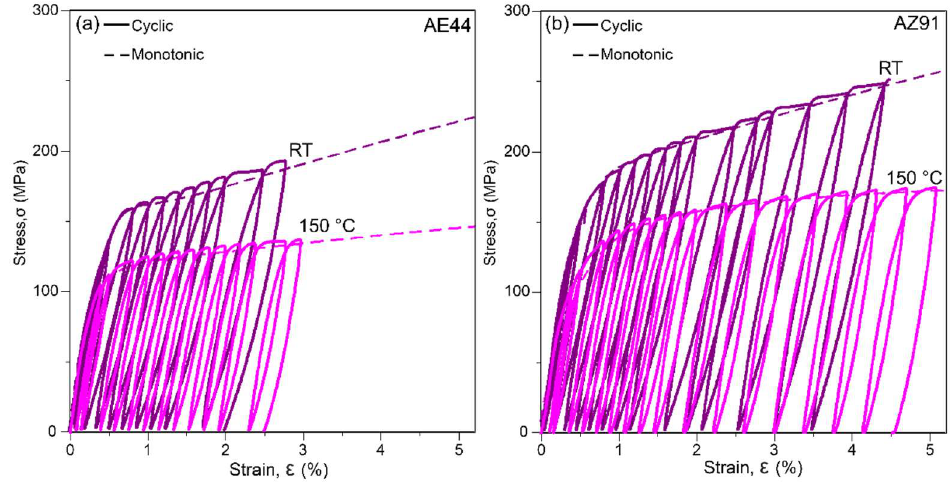
Figure 3. Examples of hysteresis loops in as-cast ( a ) AE44 and ( b ) AZ91 cycled in tension at RT and 150 °C. Dashed line represents the corresponding monotonic flow curve. Table 2. Monotonic tensile properties of studied die-cast Mg alloys at room and elevated